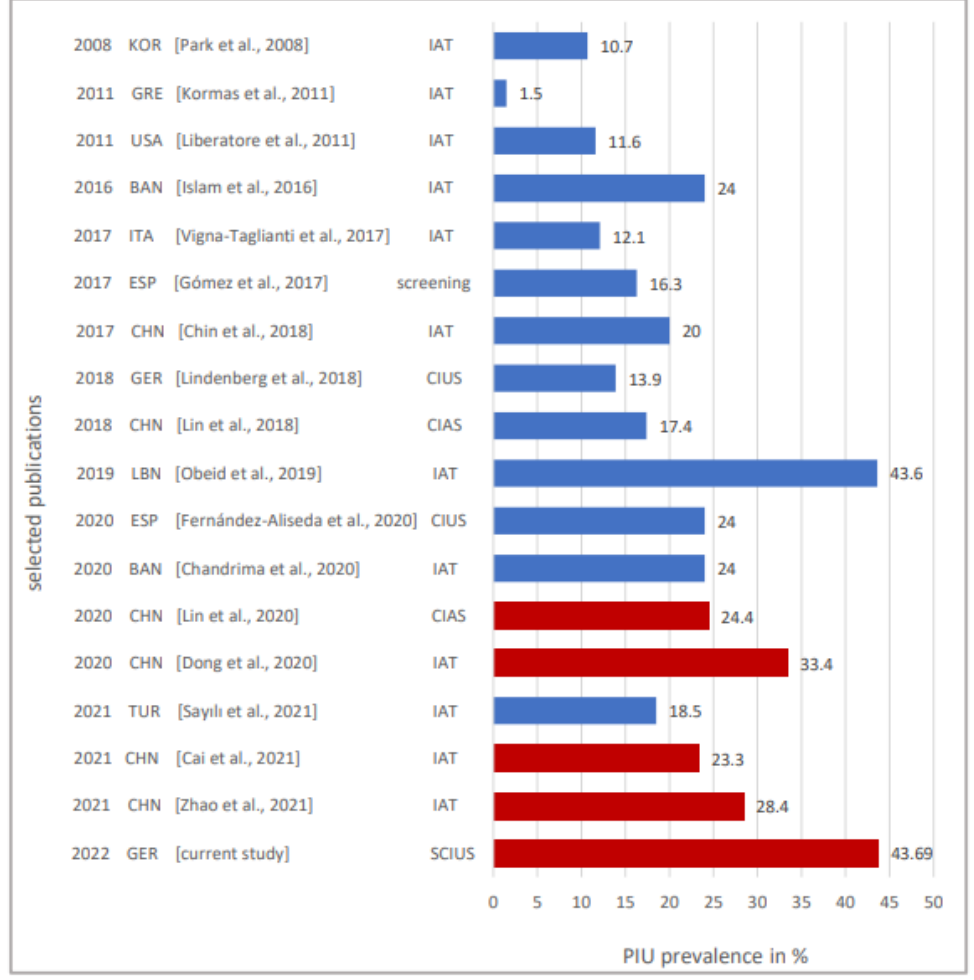
Figure 3. Selected PIU prevalence rates, depending on the year of publication, country the data were collected in and measurement instrument used. Column 1: year of publication, column 2: country (KOR = South Korea, GRE = Greece, USA = United States of America, BAN = Bangladesh, ITA = Italy, ESP = Spain, CHN = China, LBN = Lebanon, TUR = Turkey, GER = Germany), column 3: reference and column 4: measurement instrument used. Blue: data from before the pandemic were used, red: data from during the pandemic were used. Refs in figure are